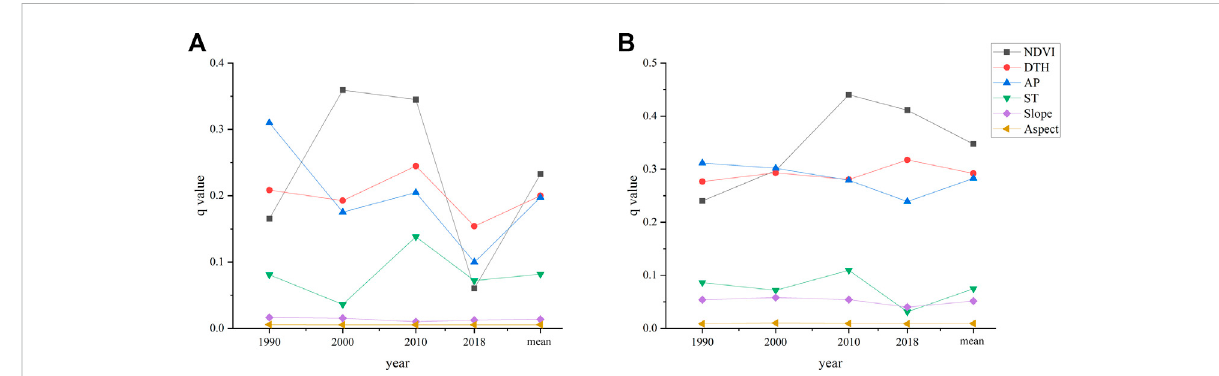
FIGURE 6 Factor detection of the spatial differentiation of ESV (A) and ERI (B) . Note: DTH, distance to highway; AP, annual precipitation; ST, soil